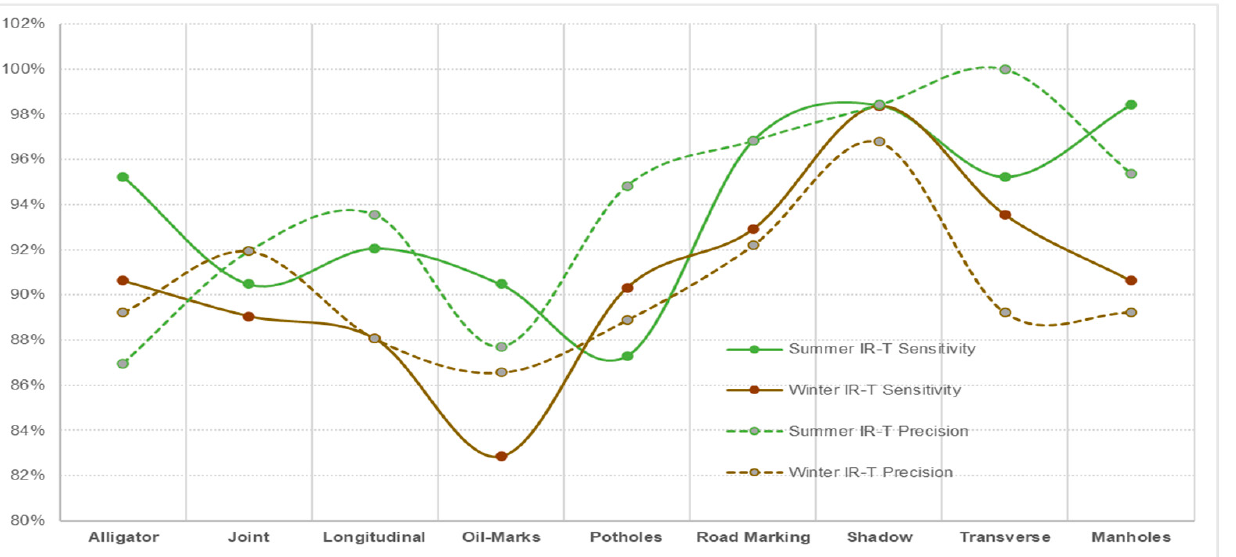
Figure 16. Comparing summer and winter conditions for IR-T images.